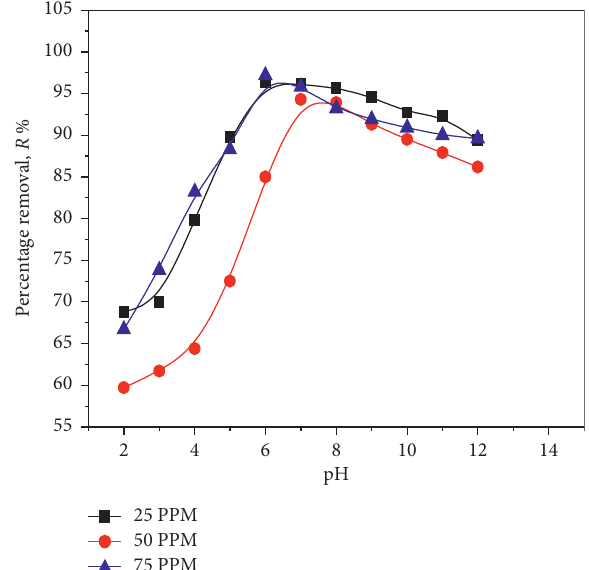
Figure 3: Effect of pH on the adsorption of the BG dye using AC.